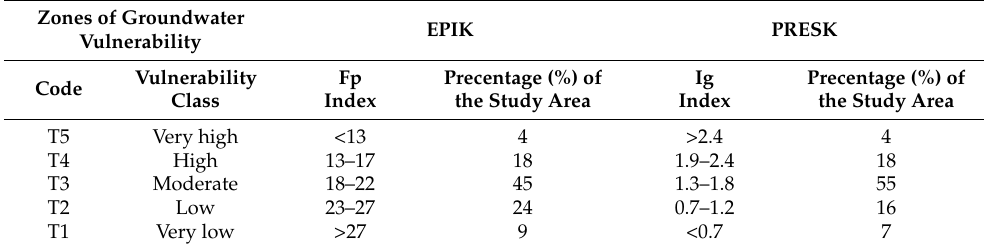
Figure 6. Soil map of the study area. It was constructed based on data gathered from the geographical maps of the land [45], and the field survey. Table 1. Zones and classes of groundwater vulnerability defined by the EPIK and PRESK method.